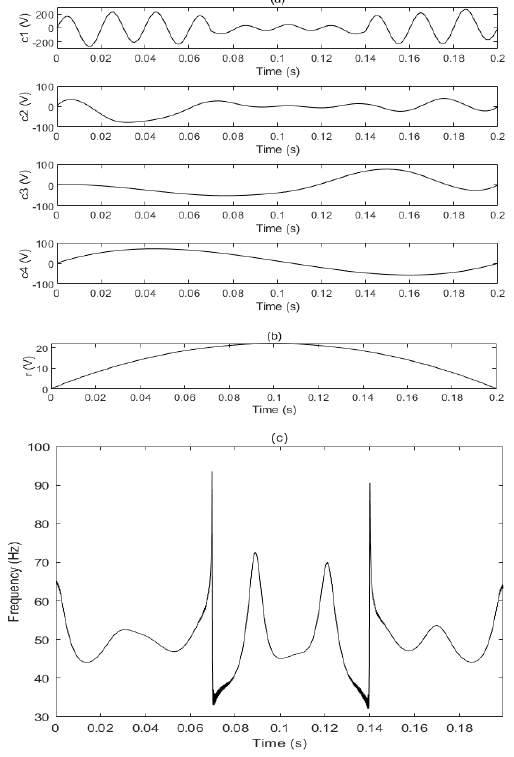
Figure 4. Voltage sag IMF components ( a ), margin ( b ), and frequency parameter ( c ).